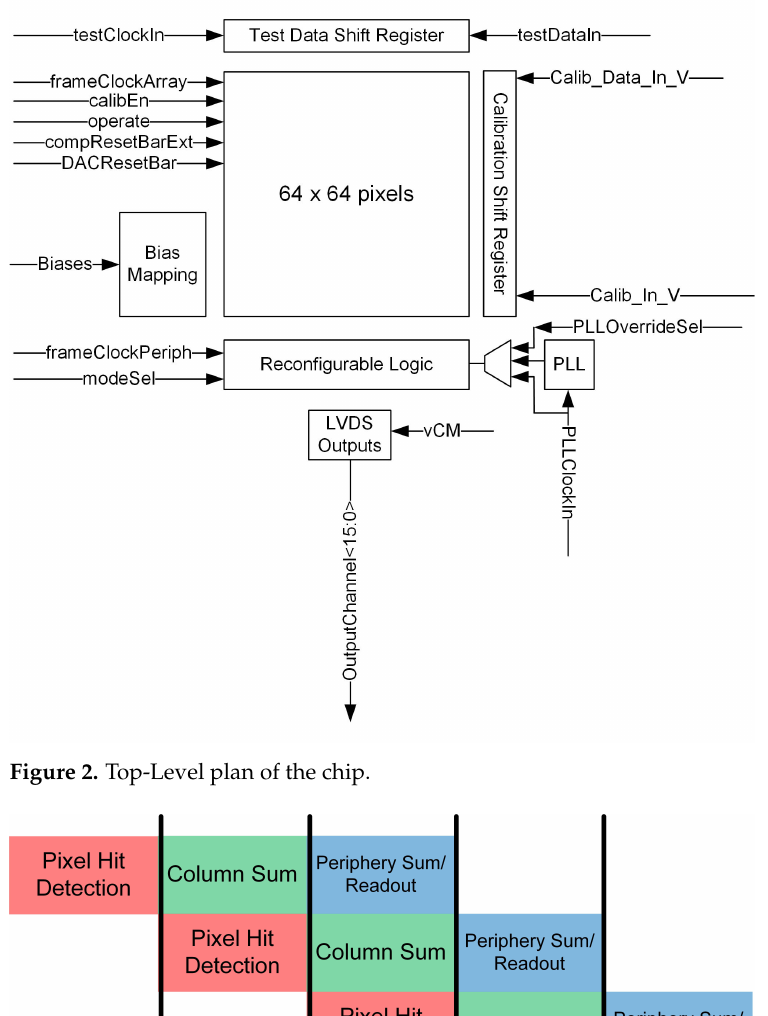
Figure 3. Illustration of the 25 ns chip readout